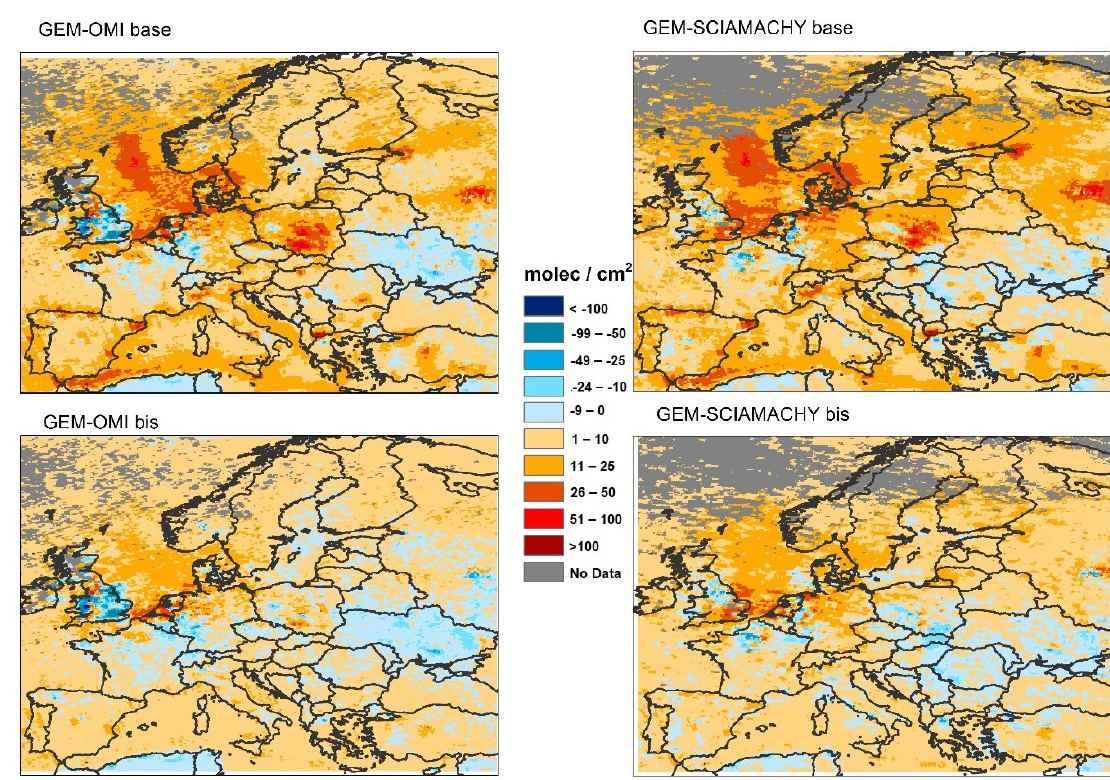
Figure 8. Differences (10 15 molec/cm 2 ) in the tropospheric NO 2 columns derived from GEM-AQ for the baseline emissions (upper row) and the modified emissions (bottom row) and satellite observations (OMI left, right SCIAMACHY) for August 2011.